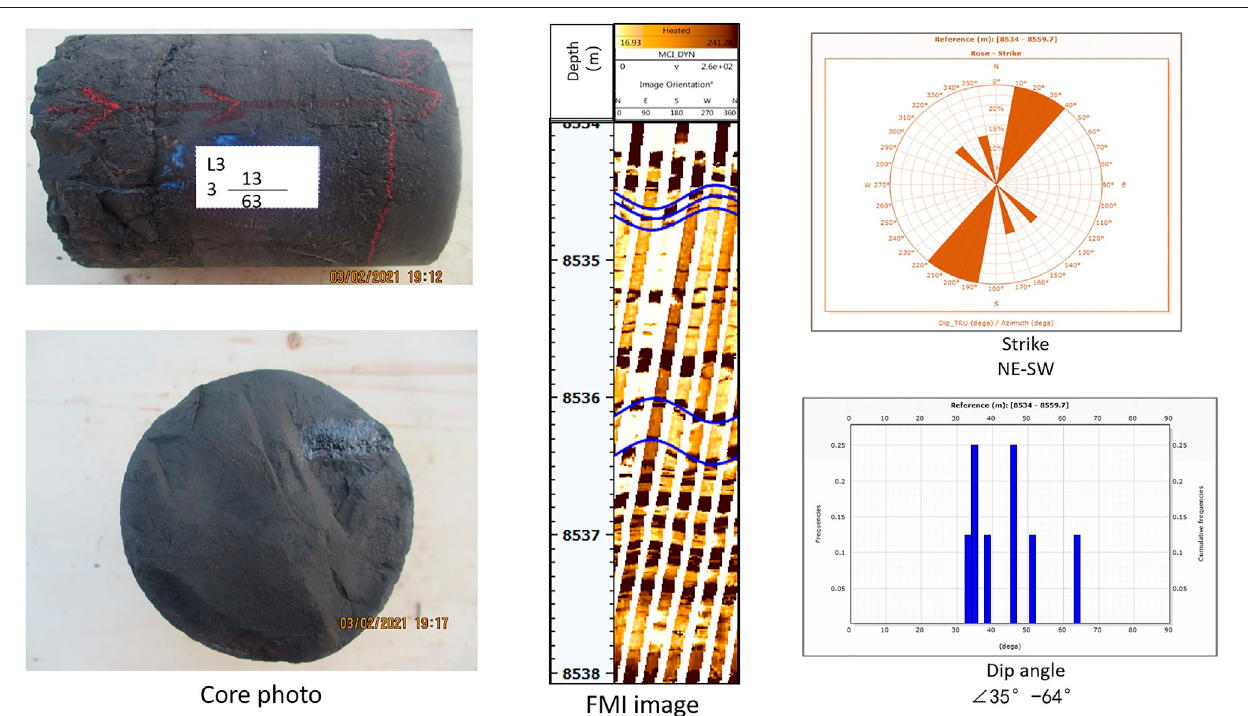
FIGURE4| Cores,imagingloggingphotos,and naturalfractureorientationsinWellL3.Theleftpictureshowspartcorephotos.Anopenhorizontalnaturalfracture can be seen, which is consistent with the natural fracture picked up by FMI logging in this section (the right picture). These natural fractures have poor transverse continuity and short longitudinal extension distance, with a medium-to-low dip angle. The effectiveness of natural fractures is poor according to these characteristics (Gong et al., 2019; Gong et al., 2021).